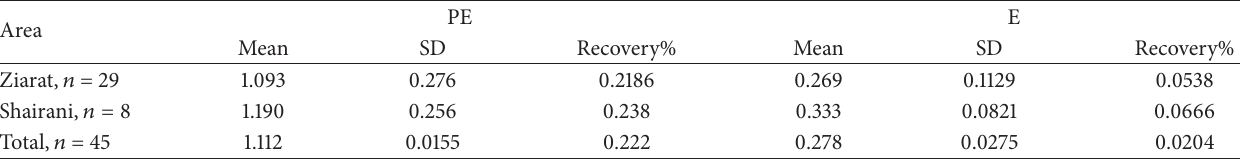
Table 2: Recovery and SD of E and PE of studied samples. 𝑛 = 45 .